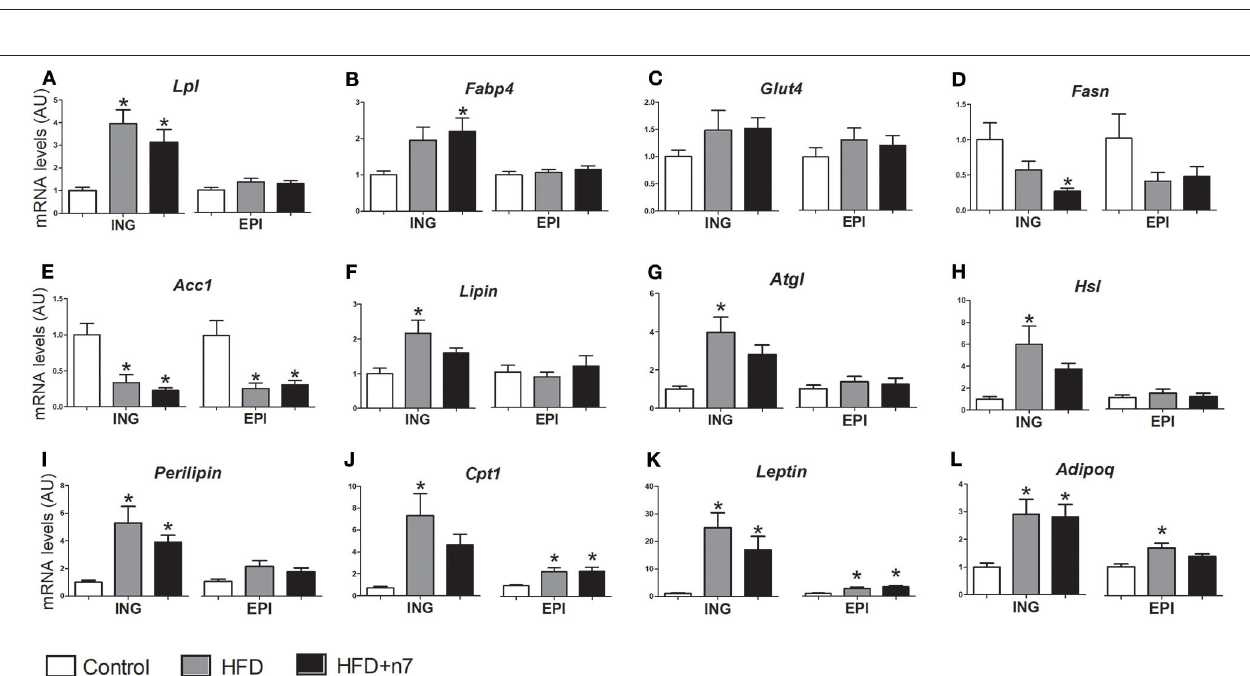
FIGURE 2 | Metabolic activities in isolated adipocytes from ING fat depot. Lipogenesis/TAG esterification in nmol/10 6 cells (A) , fatty acid oxidation in nmol/10 6 cells (B) , basal and insulin-stimulated glucose uptake in pmol/cm 2 (C) , basal and stimulated (by isoproterenol) lipolysis in nmol/10 6 cells (D) . Results were expressed as Mean ± SEM ( n = 6). Data were analyzed by one-way ANOVA. * p < 0.05 vs. control.